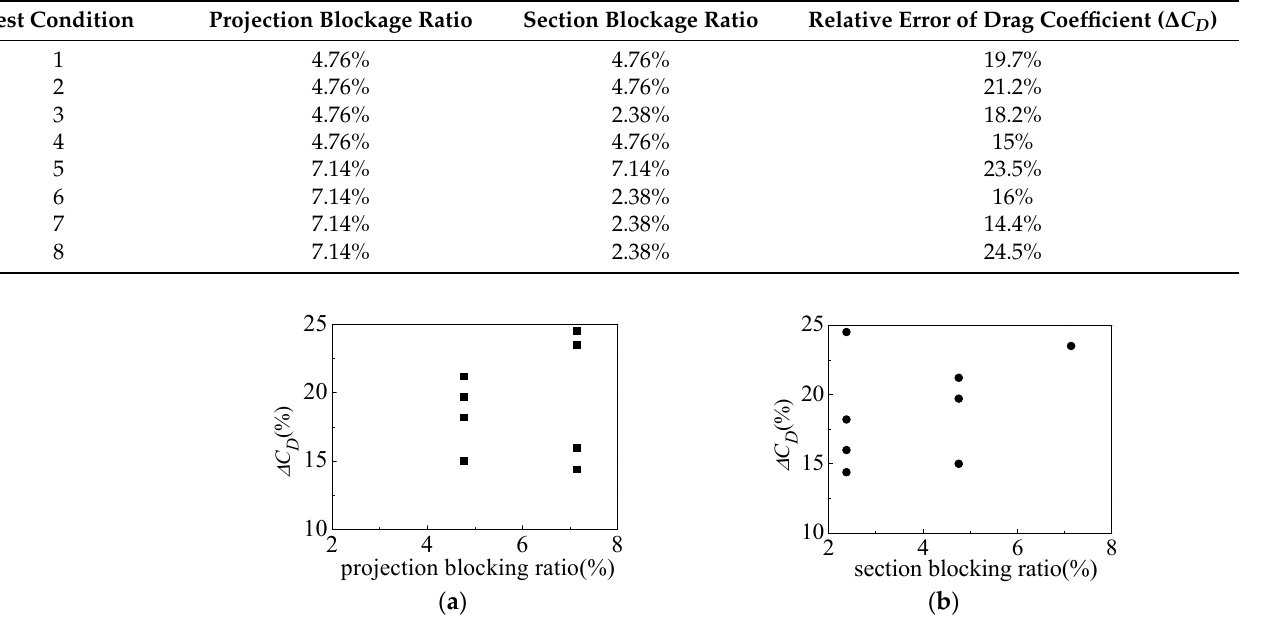
Table 5. The relative error of drag coefficient of the medium model.